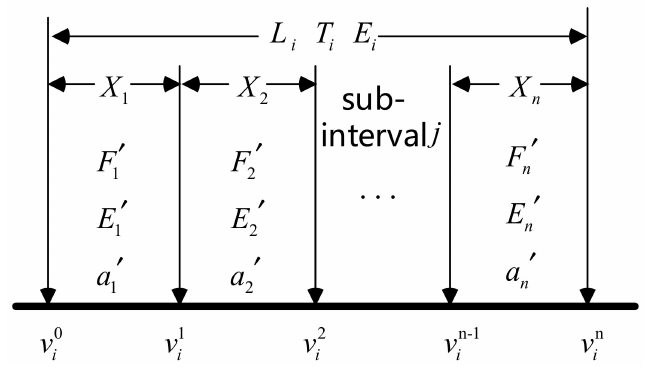
Figure 4. Subinterval